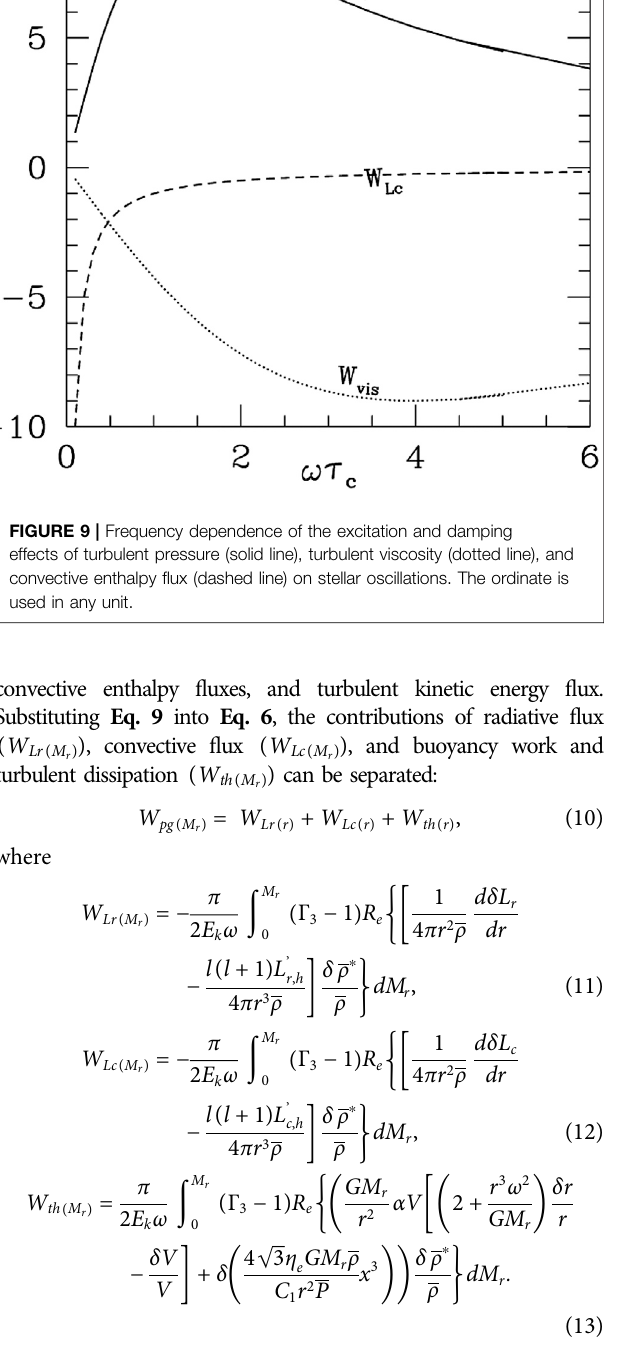
Frontiers in Astronomy and Space Sciences |